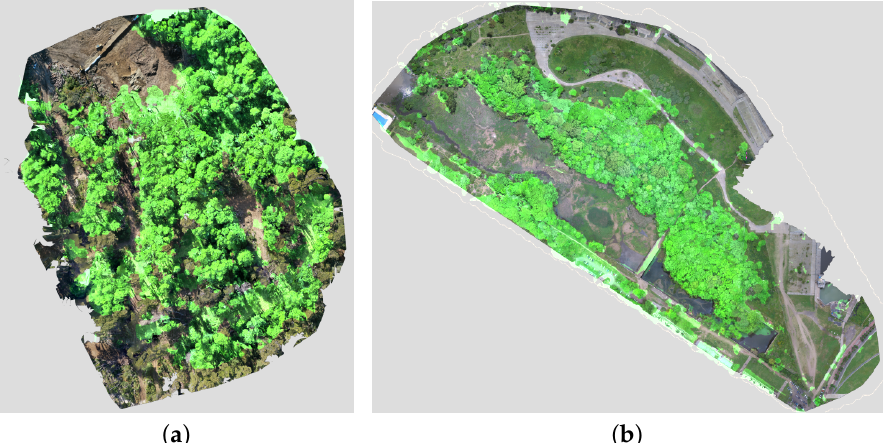
Figure 17. Overlay between orthomosaci and the areas covered by trees (fluor green) for the Villa La Angostura and RECN experiments. ( a ) VLA. ( b ) RECN.